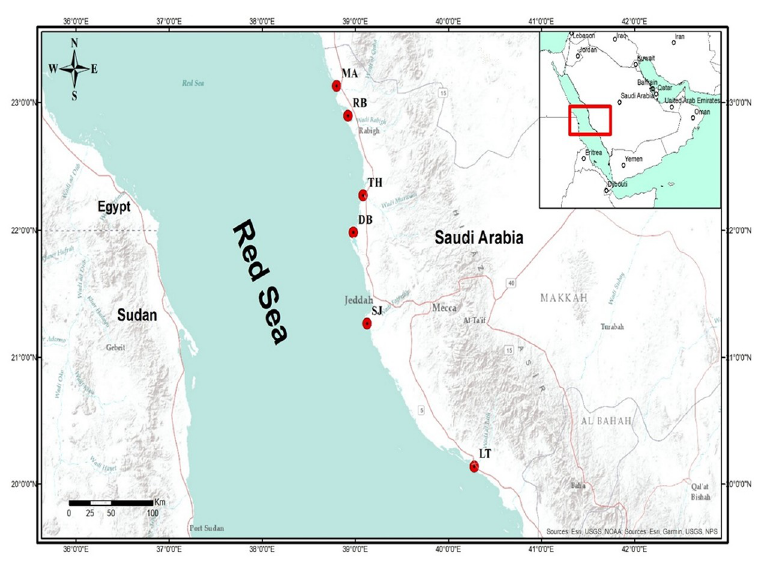
Fig 1. Sampling sites in mangrove stands located on the coast of the central Red Sea, Saudi Arabia. LT—Al Lith, SJ —South Jeddah, DB—Dahaban, TH—Thuwal, RB—Rabigh and MA–Mastorah.